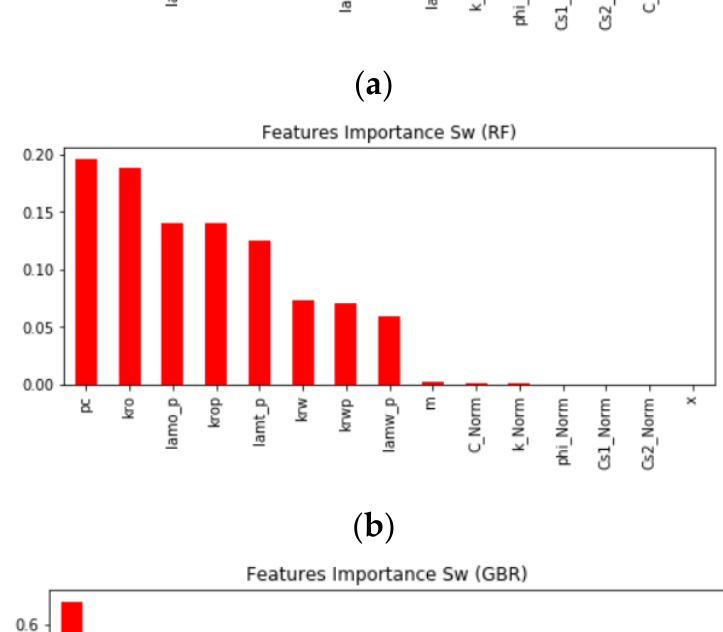
Table 5. Models performance evaluation of two phases dataset for S w .